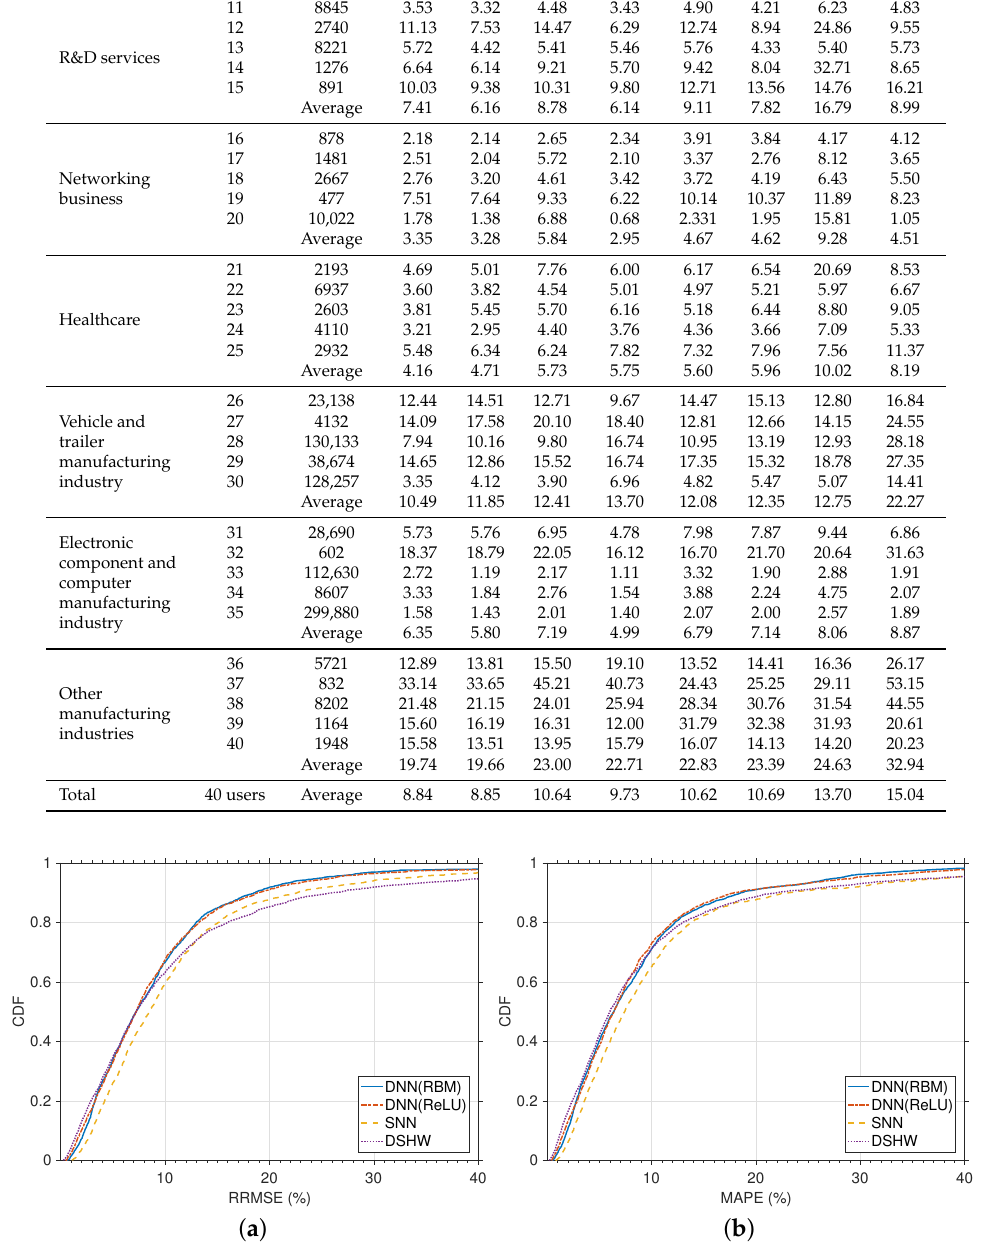
Figure 13. CDF of daily errors: ( a ) RRMSE; ( b )